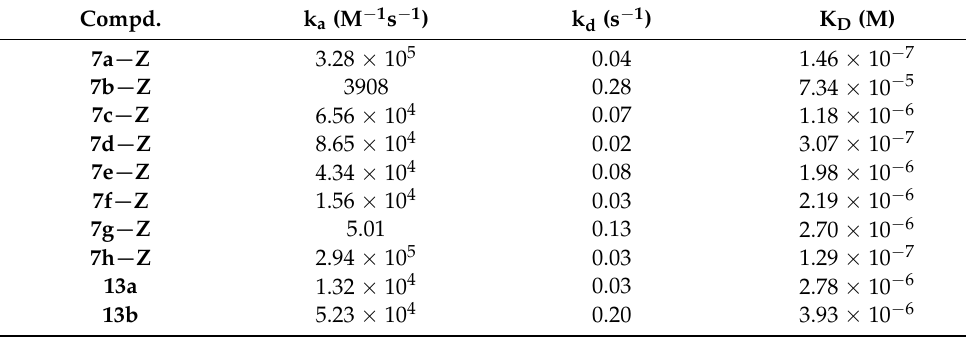
Table 3. The SPR data for the binding of active compounds.